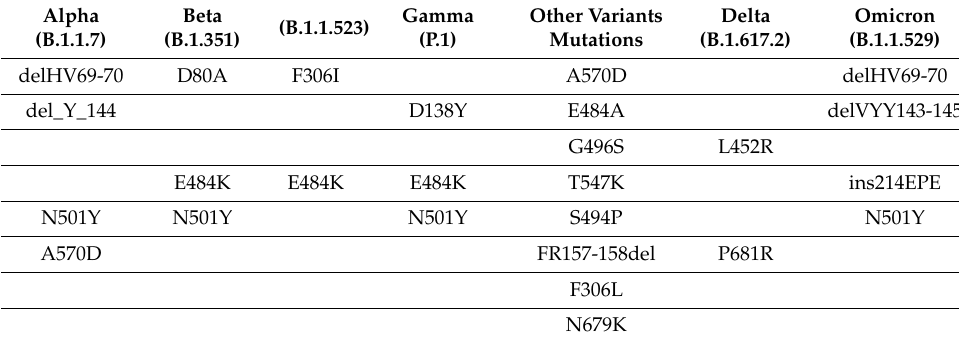
Table 1. Mutations selected for SARS-CoV-2 genotyping using real-time